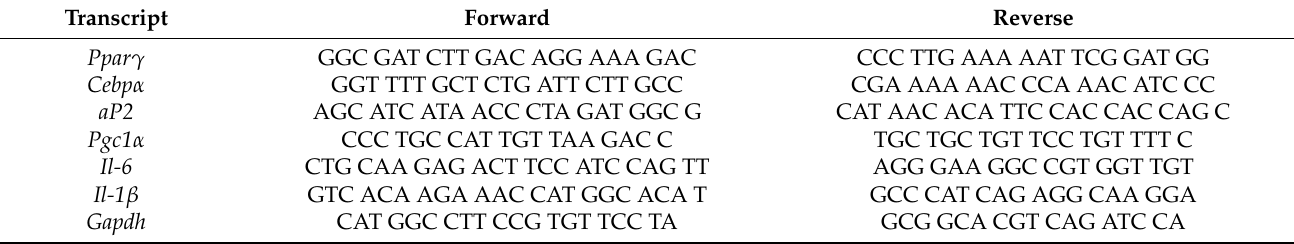
Table 5. qRT-PCR primer sequences (5 (cid:48) to 3 (cid:48)